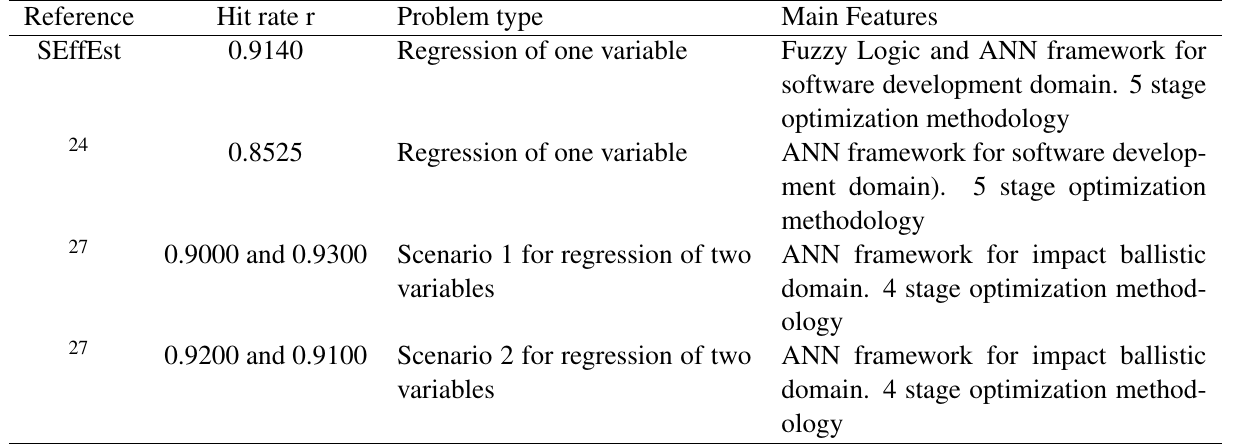
Table 14: Comparison of SEffEst with other